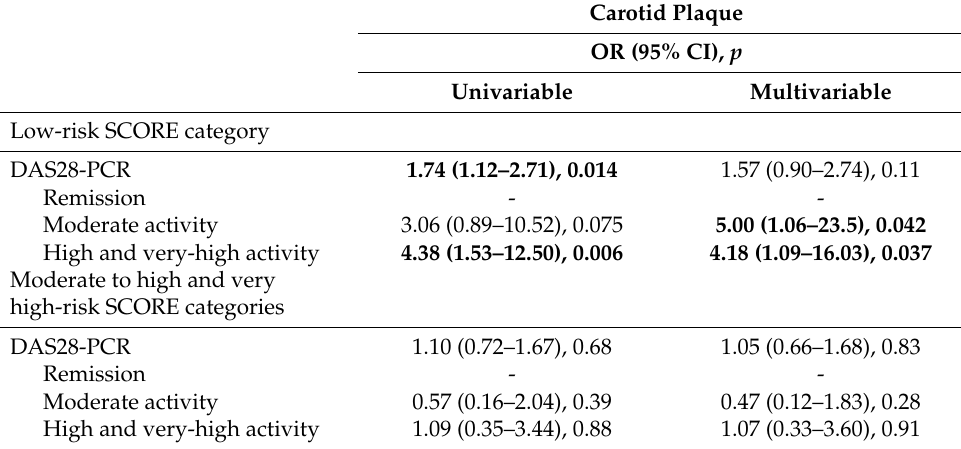
Table 3. Relationship between disease activity and the development of carotid plaque in different CV SCORE risk categories.